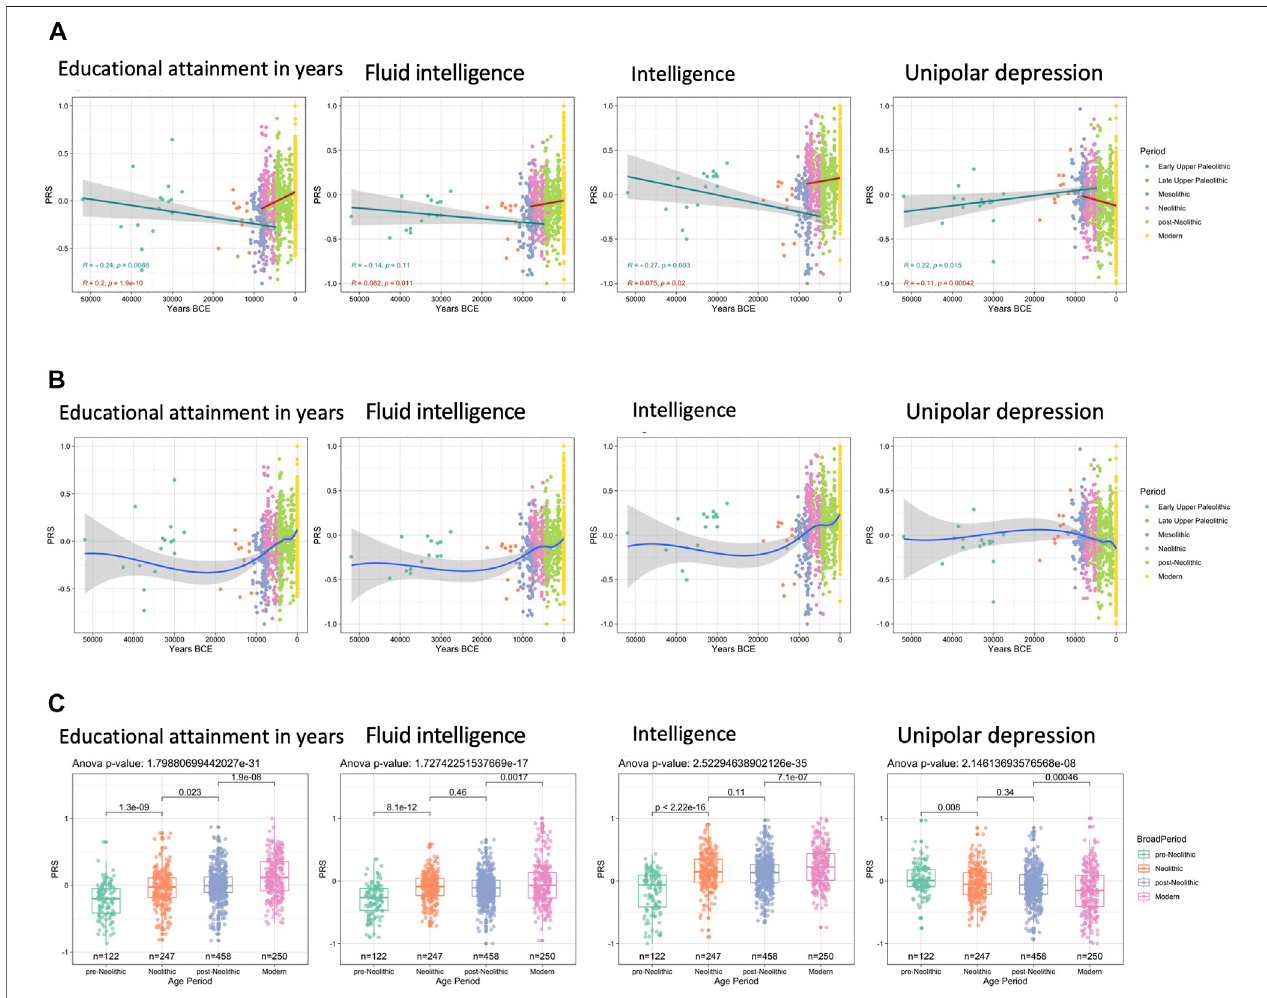
FIGURE3 | Trajectories ofhumancognition-related traits.Max missing genotype per sample: 0.96. QTL p -valuecutoff:10 – 6 . (A) Signi fi cantdecreases inPRS can beseenpriortotheNeolithicrevolutionforallcognition-relatedtraitsexcept fl uidintelligence,followedbysigni fi cantincreasesinPRSovertime.Thispatternforcognition- related traits is reversed for unipolar depression. (B) LOESS regression models show that between the Mesolithic and Neolithic, and the post-Neolithic and modern era large changes in PRS can be seen, whereas the difference between Neolithic and post-Neolithic is much smaller. (C) t -tests also show that the changes observed are signi fi cantly different to a much larger extent between the pre-Neolithic and Neolithic and between the post-Neolithic and Modern era.